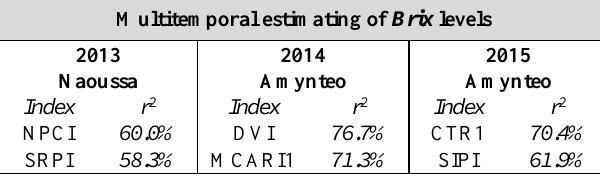
corresponding for 2014 BRIX estimation (Table 2). This is expected as BRIX and Total Acidity are usually inversely correlated. However, a further analysis indicated that inclusion of the Green band and exclusion of the Red band can optimize Total Acidity comparisons. Regression results between Total Acidity and indices involving the Green but not the Red bands scored higher. In Figure 5, the corresponding regression regarding the highest score of these experiments (Gitelson Chl1) is presented.